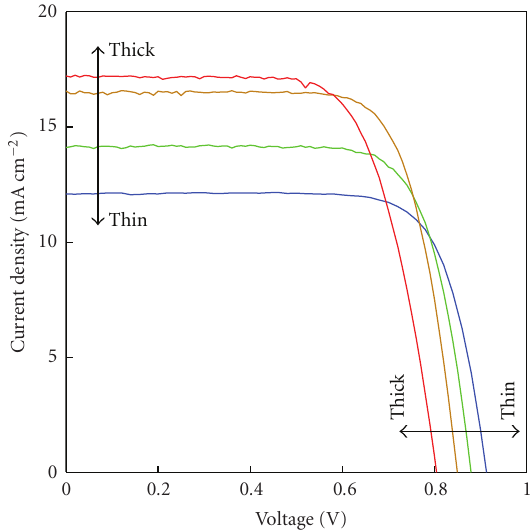
Figure 5: Photo I-V curves in relation to the thickness of double- layer nanocrystalline-TiO 2 electrodes (as shown in Figure 1(b)) with Ru dye (N719) and AcCN-based